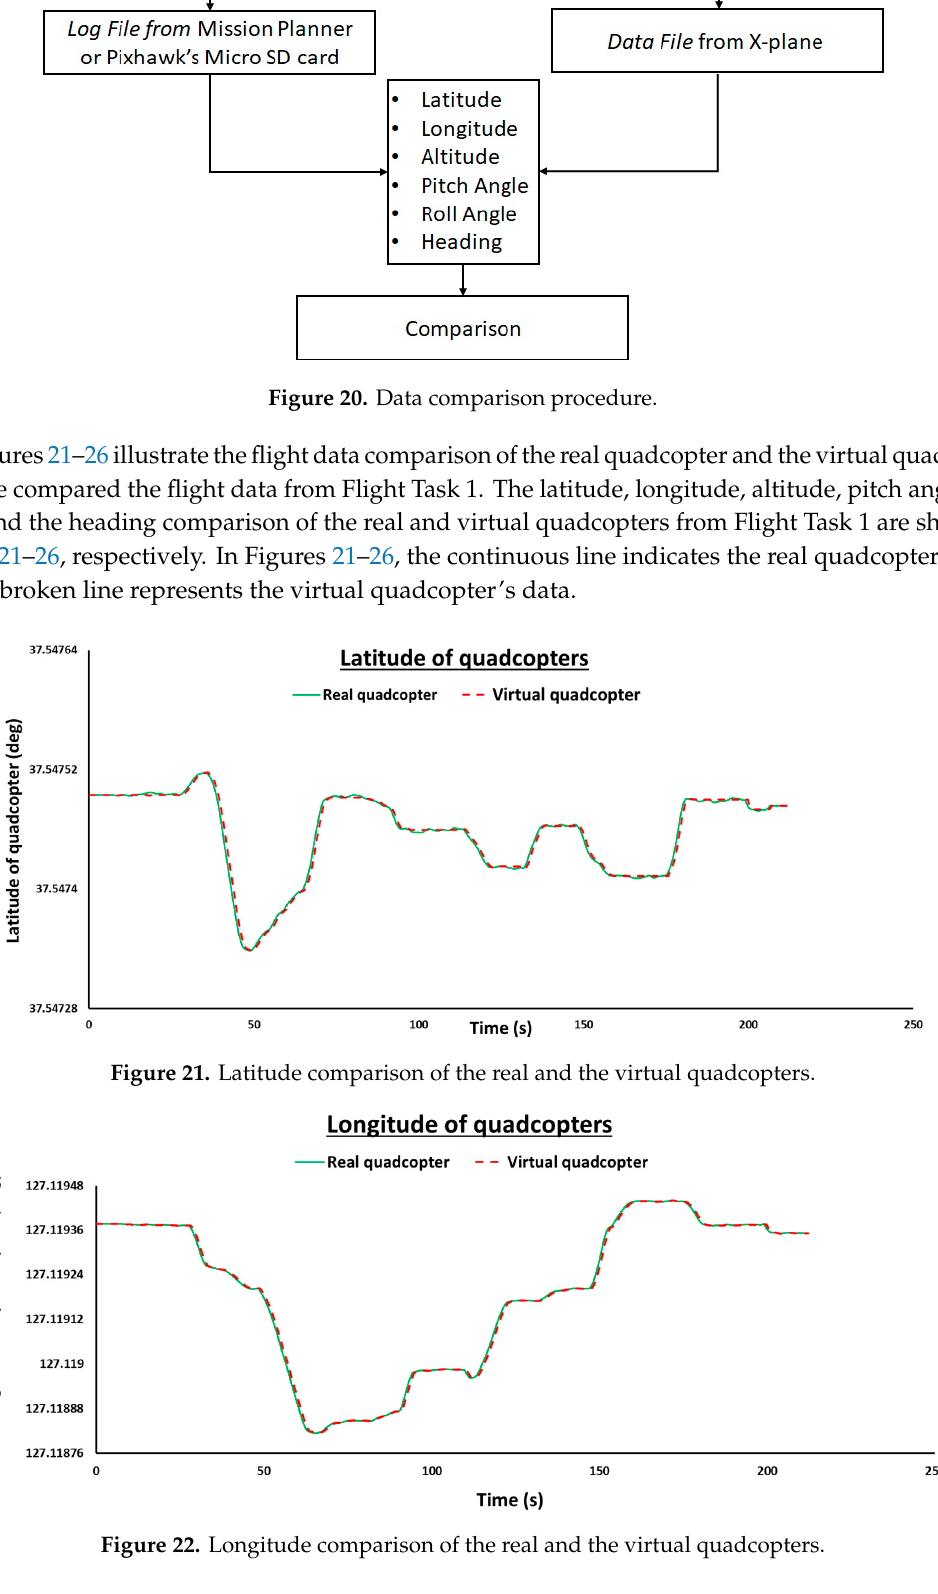
Figure 23. Altitude comparison of the real and the virtual quadcopters.